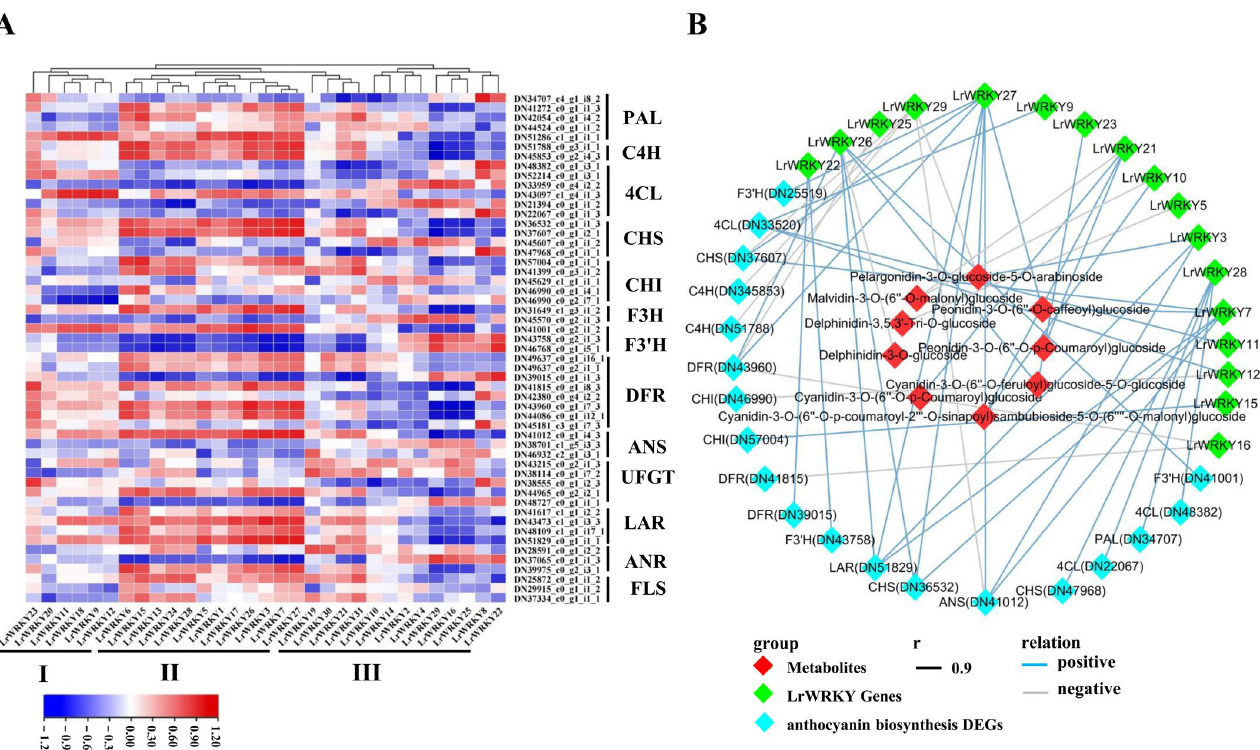
Figure 8. The regulatory network of key differently expressed genes (DEGs) of anthocyanin biosynthesis, metabolites, and LrWRKY genes in L. radiata . ( A ) The Pearson’s correlation coefficients of LrWRKYs with DEGs of anthocyanin biosynthesis in L. radiata . The enzymes include cinnamate 4-hydroxylase (C4H) , 4-coumarate:CoA ligase (4CL), phenylalanine ammonia lyase (PAL), chalcone synthase (CHS), flavone 3-hydroxylase (F3H), chalcone isomerase (CHI), flavonoid 3′ - hydroxylase (F3′H), dihydroflavonol reductase (DFR), flavonol synthase (FLS), UDP -flavonoid glucosyl transferase (UFGT), anthocyanidin synthetase (ANS), anthocyanidin reductase (ANR), and leucoanthocyanidin reductase (LAR). ( B ) Correlation network of metabolite-related LrWRKY genes and DEGs involved in anthocyanin biosynthetic pathways. r represents the Pearson correlation coefficient; relation represents the correlation, including positive (r > 0.9) and negative correlations (r < − 0.9).